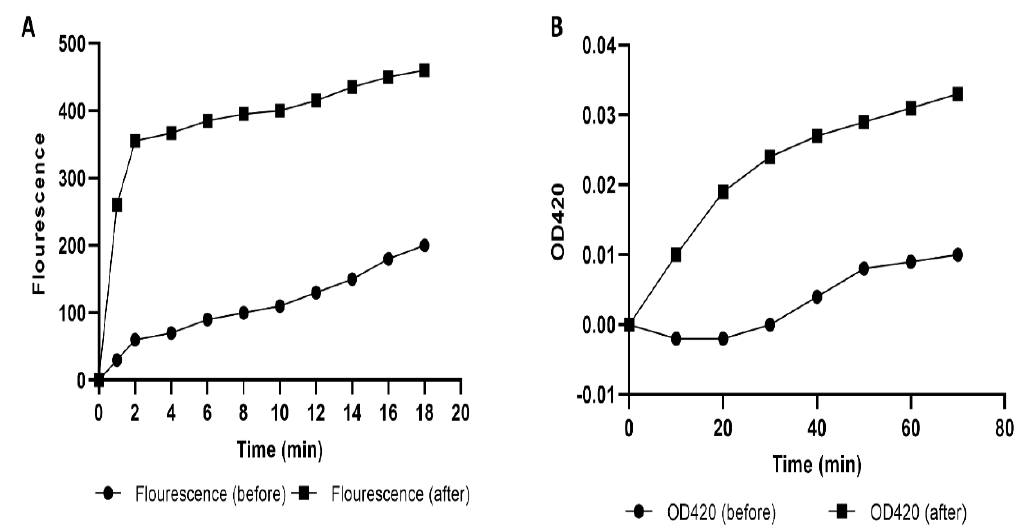
Figure 3. An illustrative example of A. baumannii isolate (A1) shows a significant rise in ( A ) the outer membrane permeability and ( B ) the inner membrane permeability after treatment with SAME.